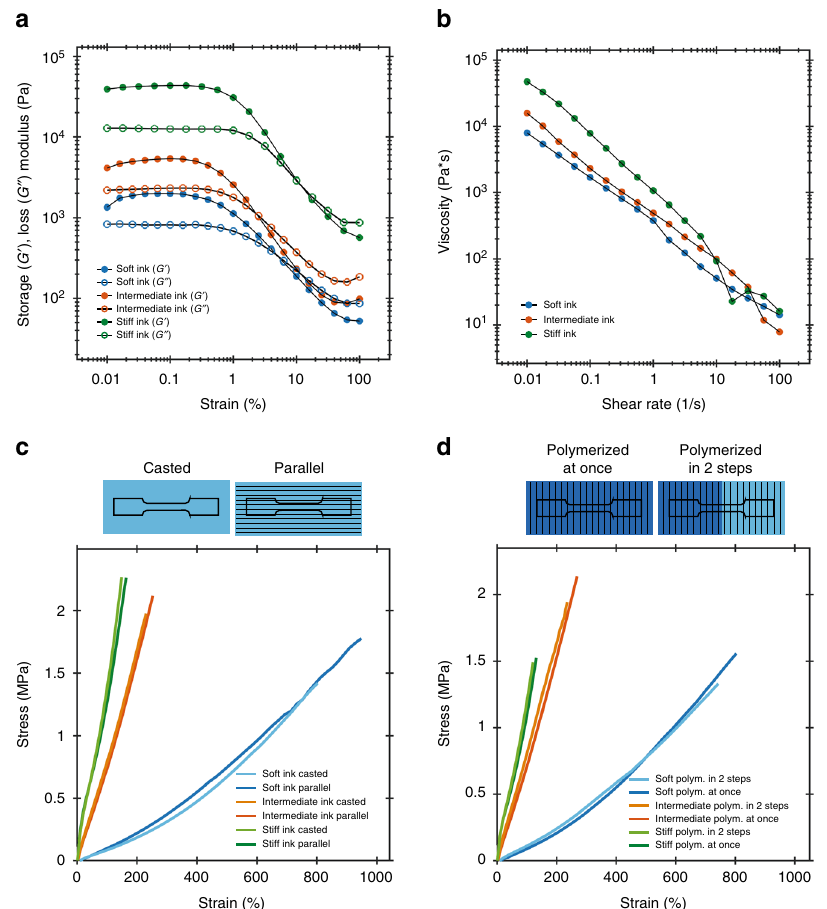
Fig. 2 Rheological properties of Silinks and mechanical behavior of printed inks after polymerization. a Storage modulus, G ʹ , and loss modulus, G ʹʹ , of the soft, intermediate, and stiff Silink as a function of the strain amplitude applied in an oscillatory sweep measurement. Crossovers at high strains indicate the presence of a predominantly elastic network at rest, which is crucial for shape retention after extrusion. b All Silinks exhibit shear-thinning behavior visible by the decrease in viscosity at higher shear rates under steady-state conditions. In combination with the viscoelastic network formation, shear thinning guarantees a consistent fl ow through the nozzle and enables high printing accuracy with a spatial resolution as low as 300 µ m. c Soft, intermediate, and stiff Silinks tested parallel to the printing direction and compared to casted samples. Printing does not adversely affect the rupture strengths of the Silinks. d In fl uence of the polymerization protocol on the bonding strength between printed fi laments. Continuous fi lms polymerized post printing are compared to a fi lm with polymerization halfway through the print. The bonding strength between fi laments directly polymerized after deposition is not affected in comparison to a fi lm deposited continuously in one run and polymerized after printing. All samples were tested perpendicular to the printing